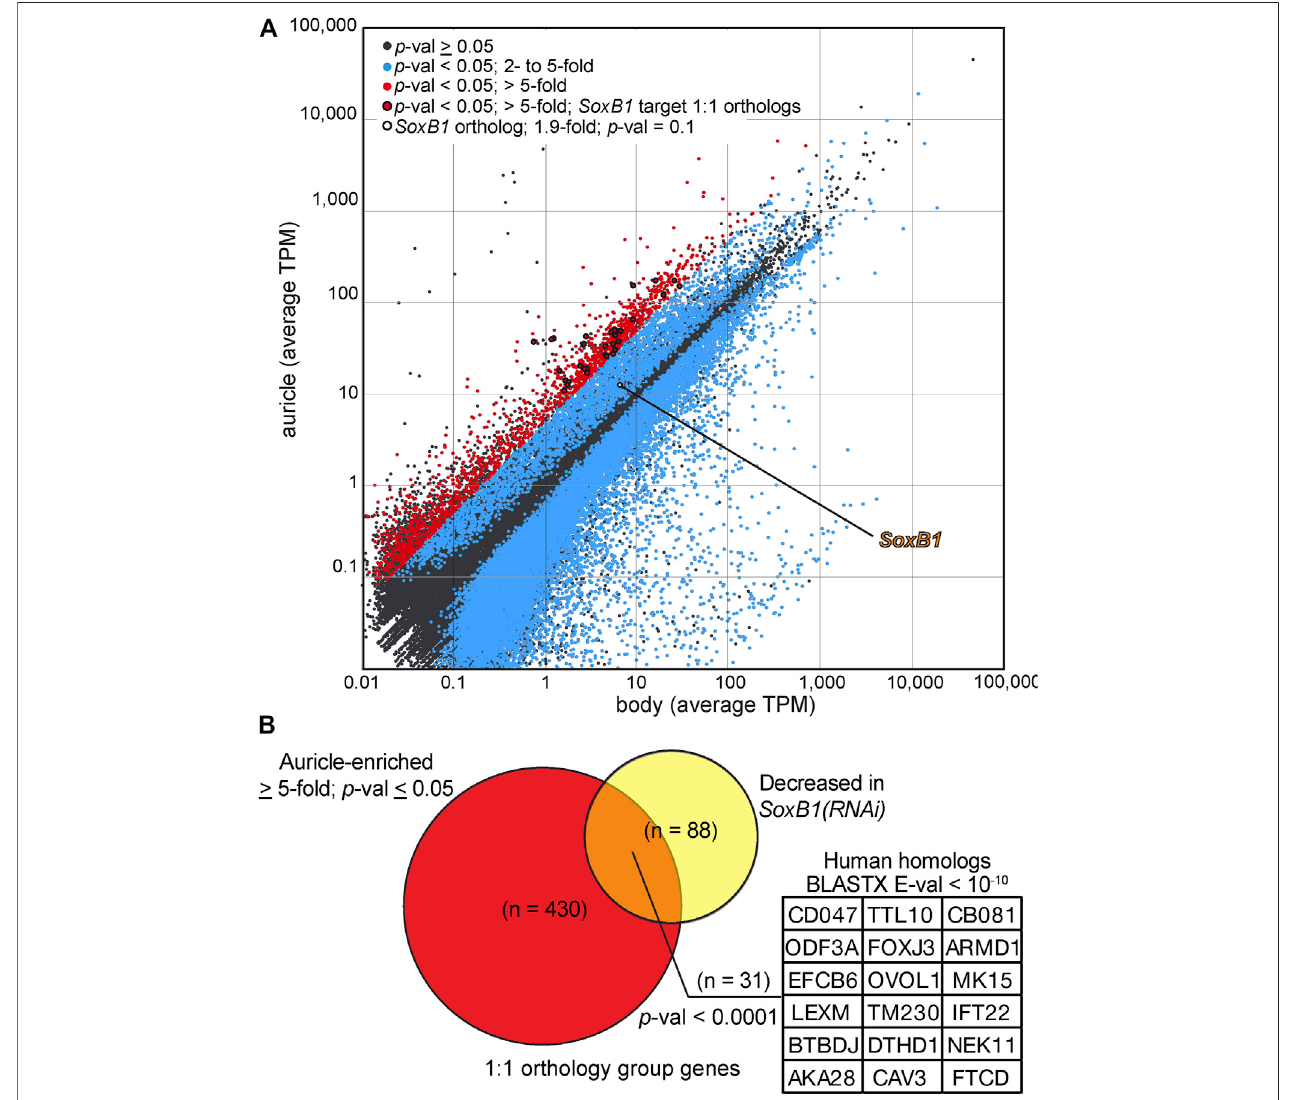
FIGURE 7 | Analysis of auricle gene expression by RNAseq. (A) Log plot of average transcripts per million (TPM) calculated from Illumina reads of RNA extracted from G. dorotocephala auricles ( y axis) and bodies ( x axis) mapped to reference transcriptome contigs. Contigs with (Student ’ s t- test, p- val < 0.05; blue) and without (gray) statistically signi fi cant differences in relative gene expression are marked. Contigs with statistically signi fi cant difference in gene expression and ≥ 5-fold enriched abundanceinreadsofauriclesareshowninred.Pointsrepresentingthe G.dorotocephala orthologof Smed-SoxB1 (whitewithblackcircumference)aswellgenes corresponding to those listed in panel (B) (red with black circumference) are highlighted. (B) Venn diagram showing the overlap of 1:1 orthologs between sequences enriched in the auricle ( > 5-fold) of G. dorotocephala (red) and sequences with decreased expression 14- and 24-days into Sox-B1 RNAiin S. mediterranea (Ross et al., 2018; yellow). Inset lists top human matches with E-value ≤ E10 -10 from BLASTX searchers of G. dorotocephala sequences in orthology groups represented in the intersection of the Venn diagram.